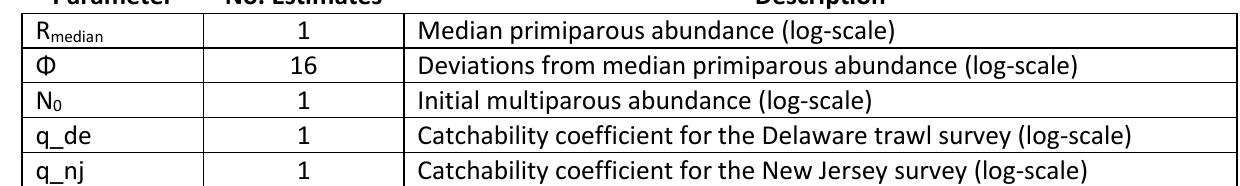
Table 44. The number of parameters estimated in the catch multiple survey analysis: median primiparous abundance (1); primiparous abundance for each year (16); catchability coefficients (2) for the Delaware and New Jersey surveys; and multiparous abundance for the start of the time series (1).